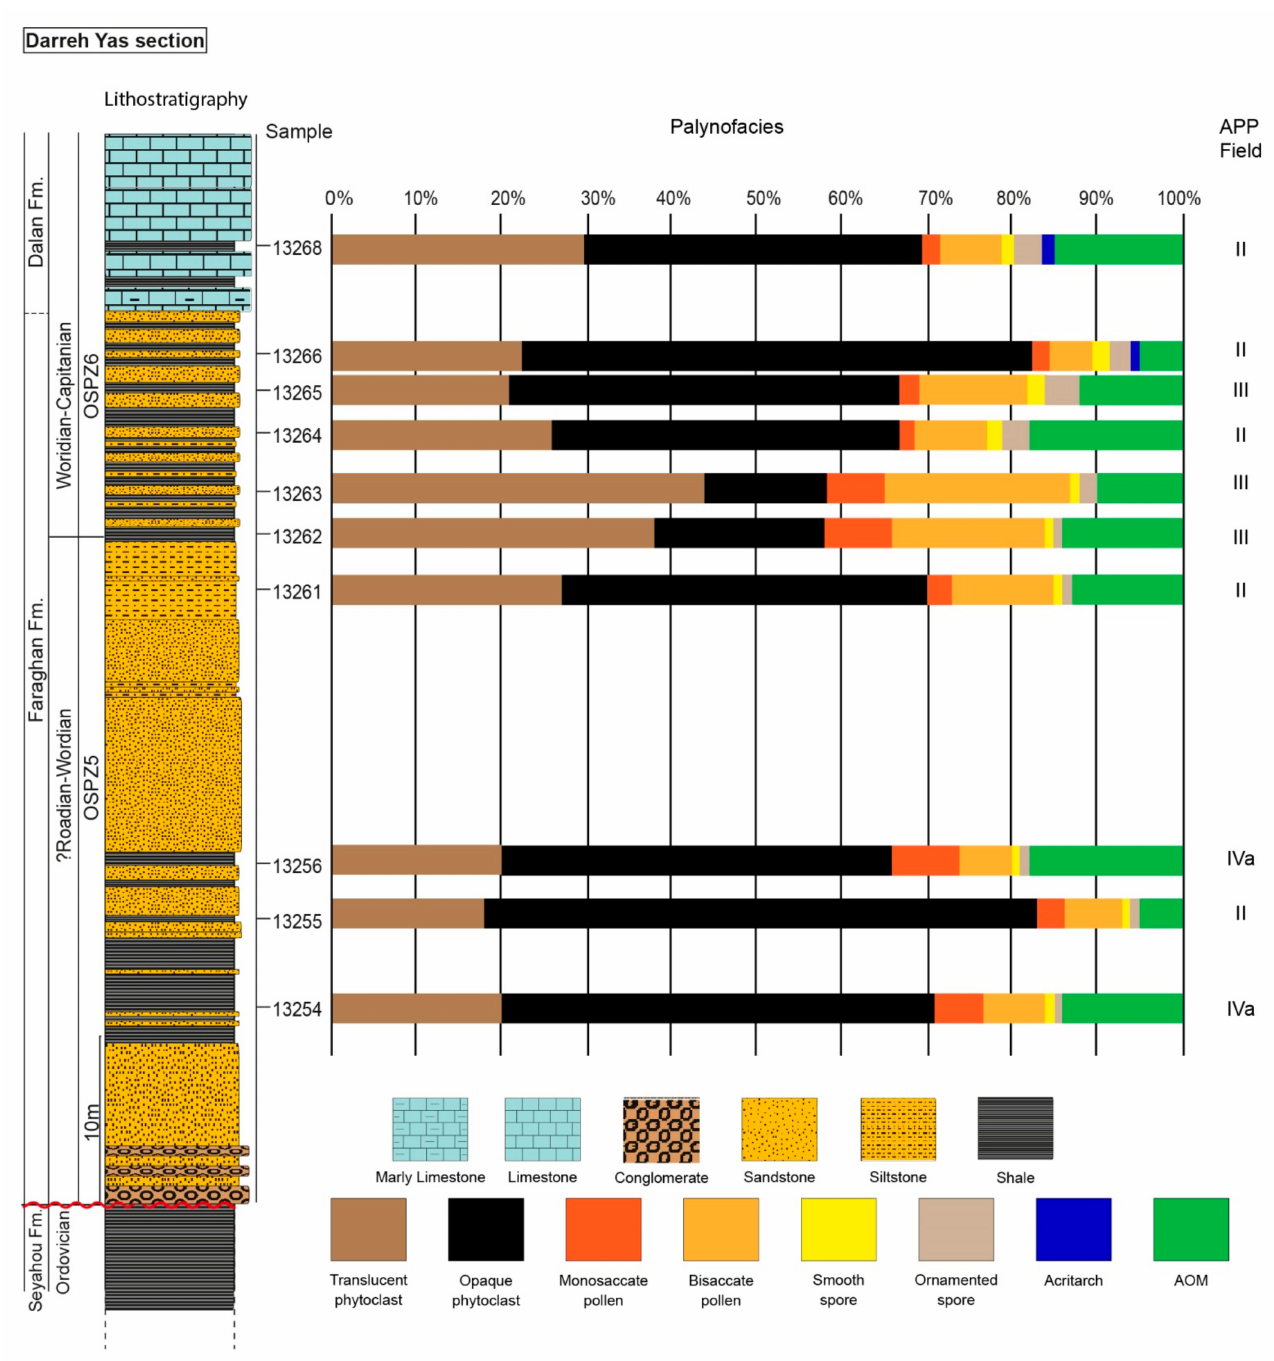
Figure 2. Stratigraphic log, sampled horizons and palynofacies of the Faraghan Formation at the Darreh Yas